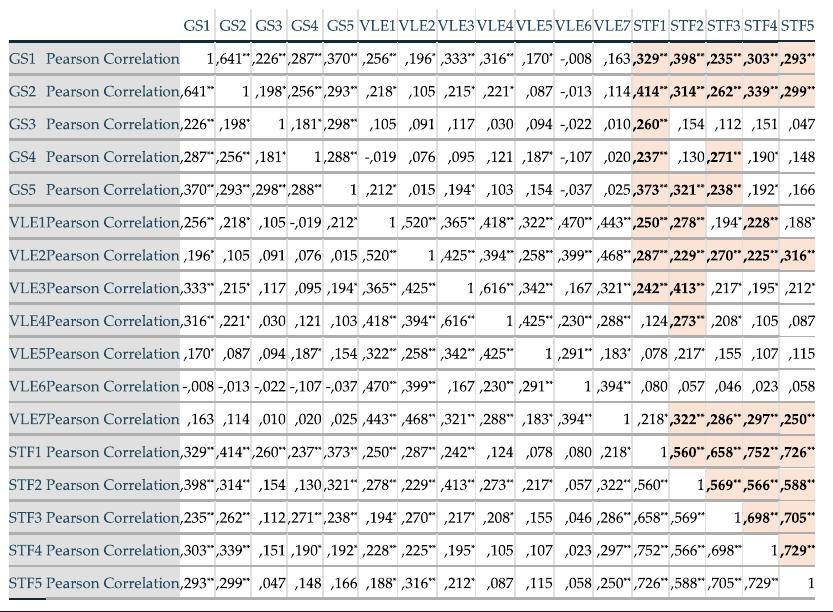
Table 13 Correlations among